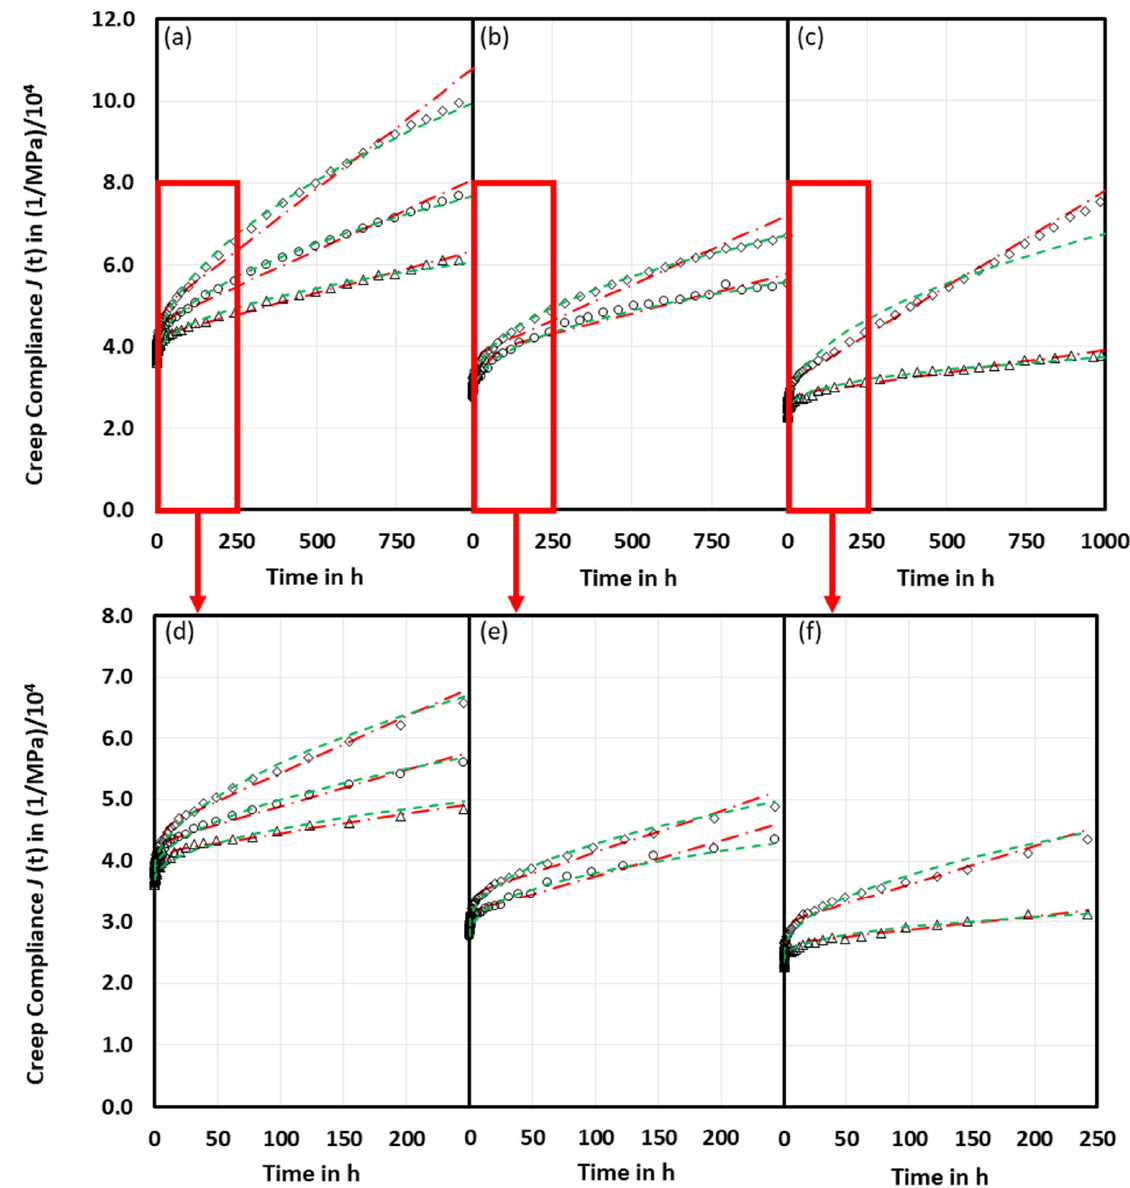
Figure 1. Measured creep compliances (symbols) of neat PBT ( a , d ), PBT GB20 ( b , e ), and PBT GB30 ( c , f ) fitted with Burgers model (dash‑point line) and Findley power law model (dashed line) with initial stresses σ 0 = 11 MPa ( ∆ ), 17 MPa ( o ), and 22 ( ♢ ) MPa; time intervals of fitting were 1000 h ( a – c ) and 250 h ( d – f